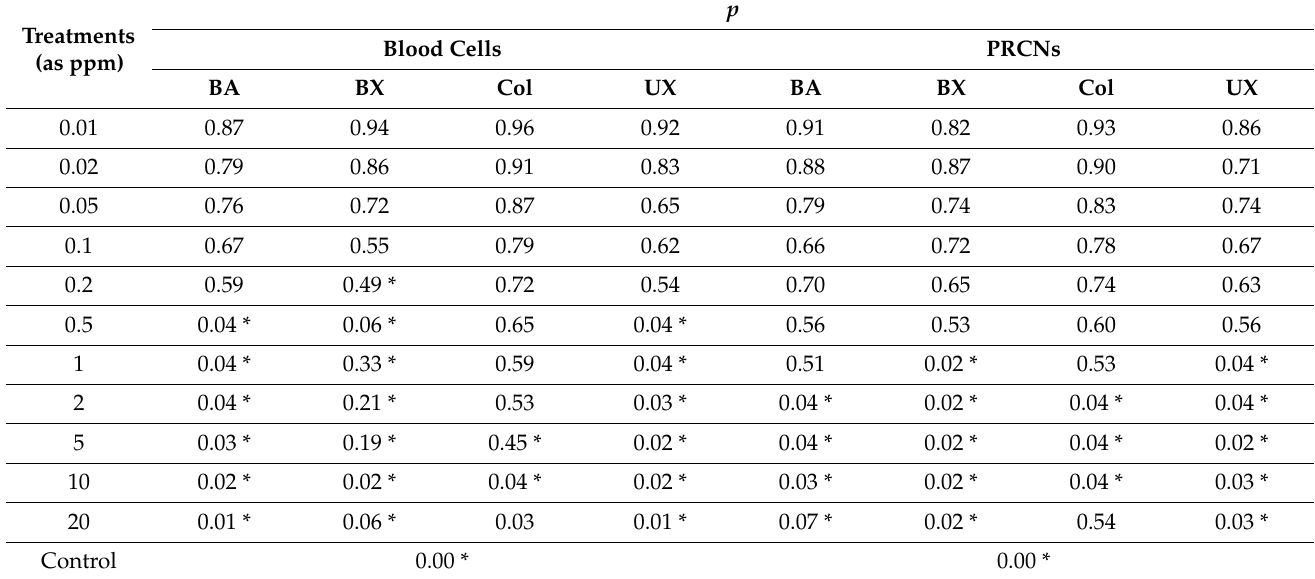
Table 2. The cytotoxicity of co-applications with boron compounds and Al in comparison to only Al-treated